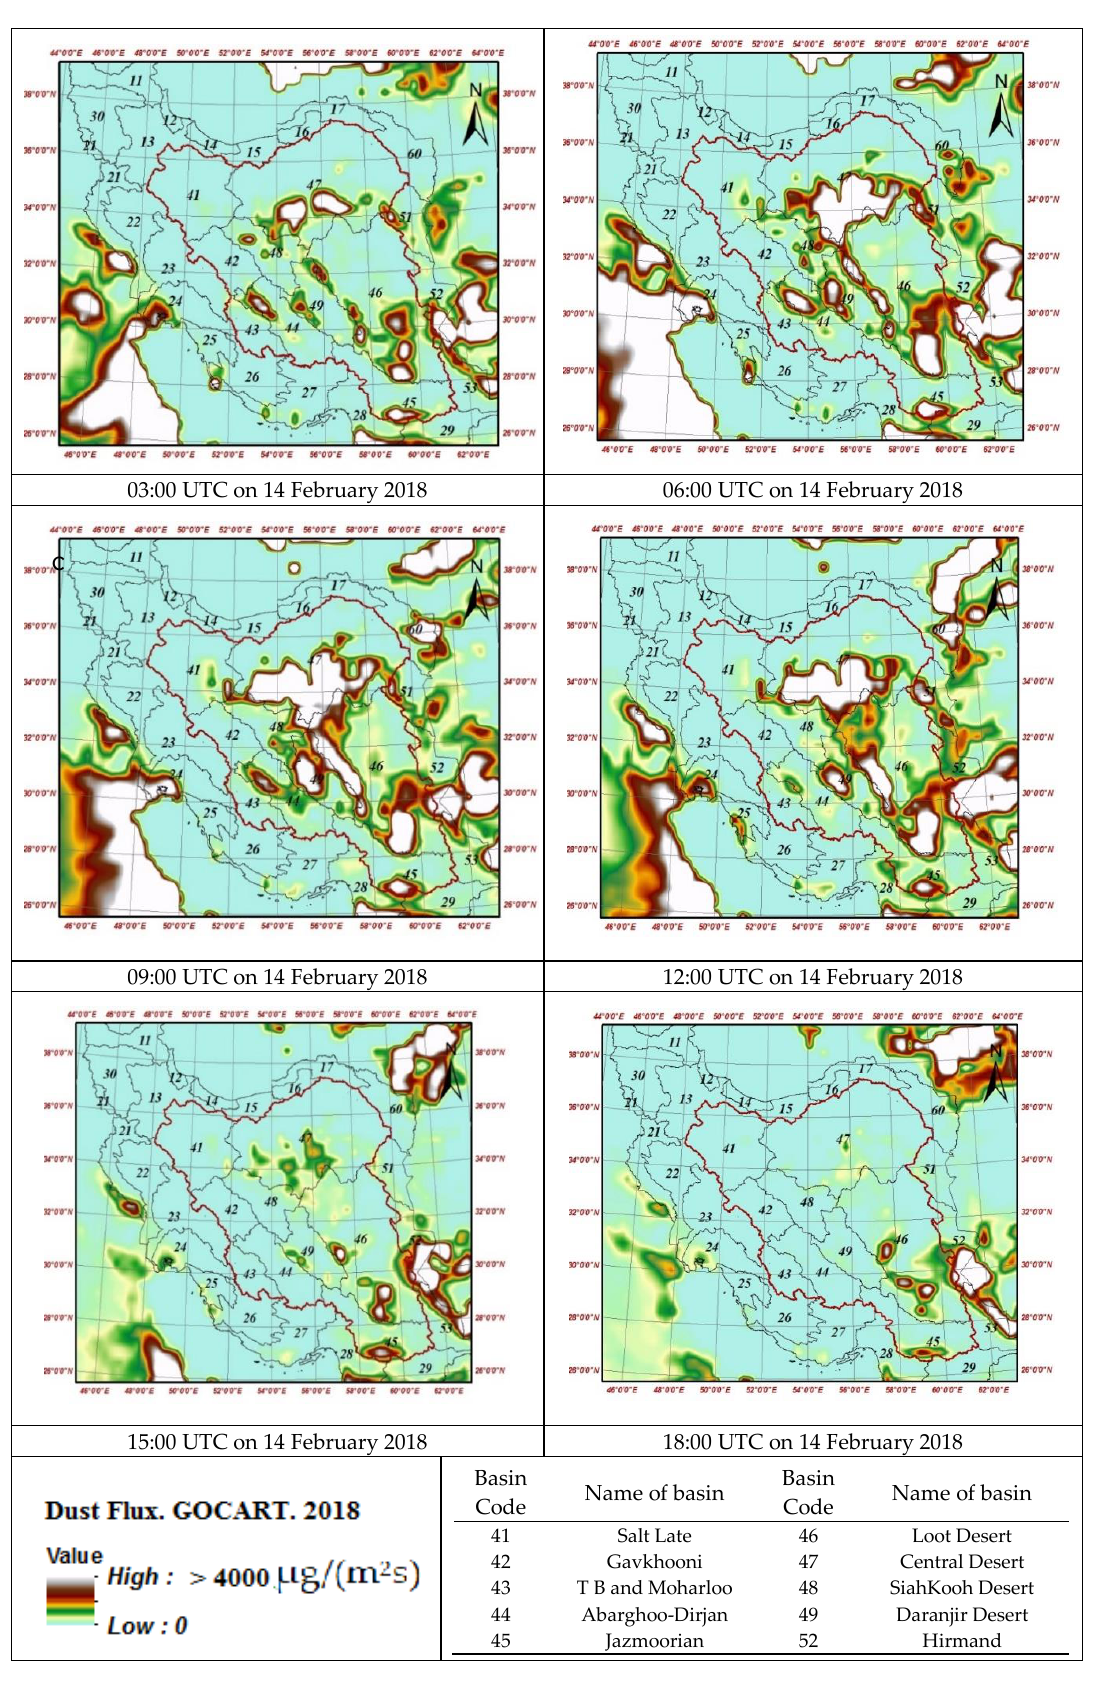
Figure 8. Spatial pattern of dust flux ( µ g / m 2 s) with 3 h interval by Global Ozone Chemistry Aerosol Radiation and Transport (GOCART)